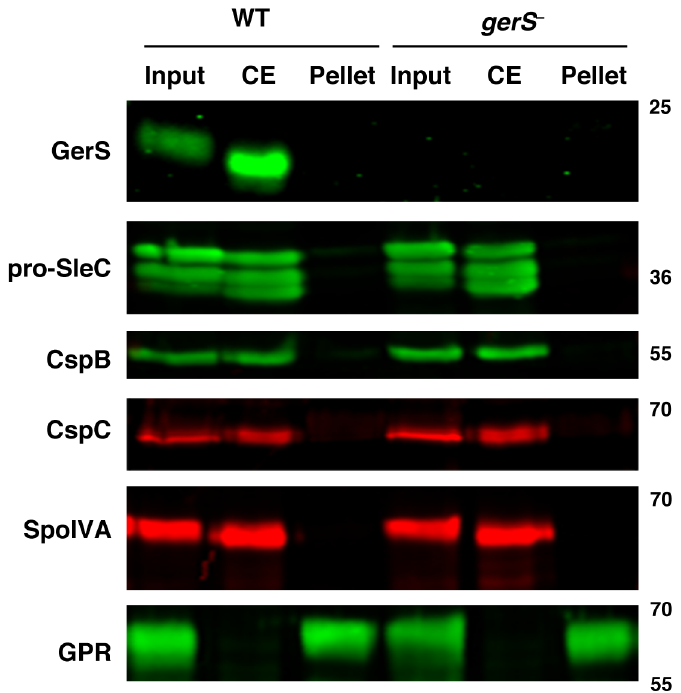
Fig 6. Germination proteins localize to a “ coat-extractable ” (CE) fraction. Western blot analyses of “ coat-extractable ” (CE) and decoated spore lysate (pellet) fractions from wildtype and gerS − spores. It should be noted that the CE fraction likely includes proteins localized to the cortex and outer-forespore membrane. Input represents the whole spore lysate without fractionation. SpoIVA is a coat morphogenetic protein [60]. GPR (germination protease) is localized to the core of spores